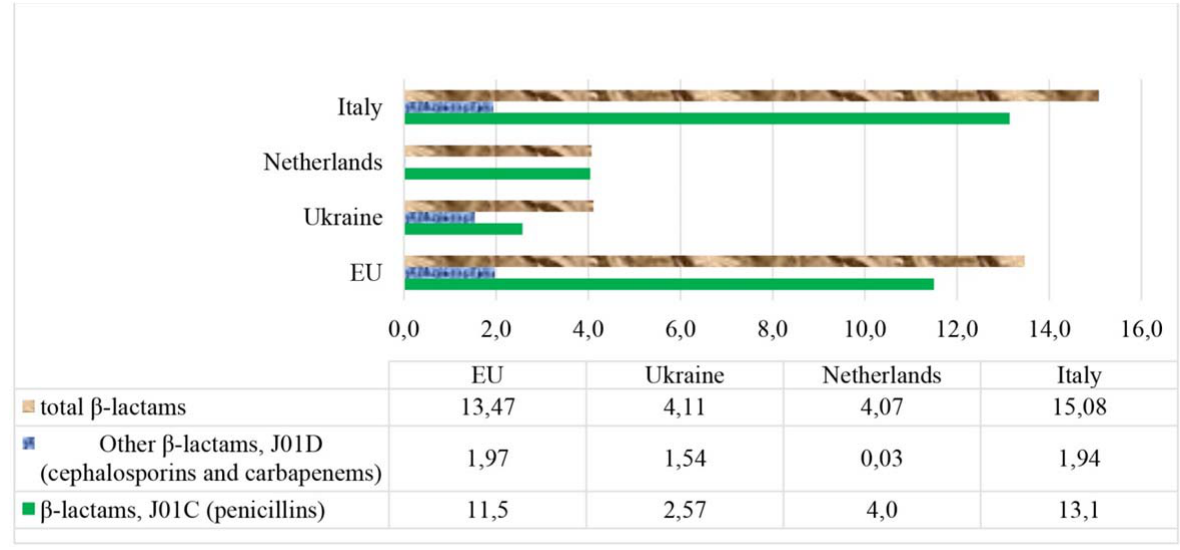
Fig. 1. Consumption of AMI β -lactams group in 2017 in DID